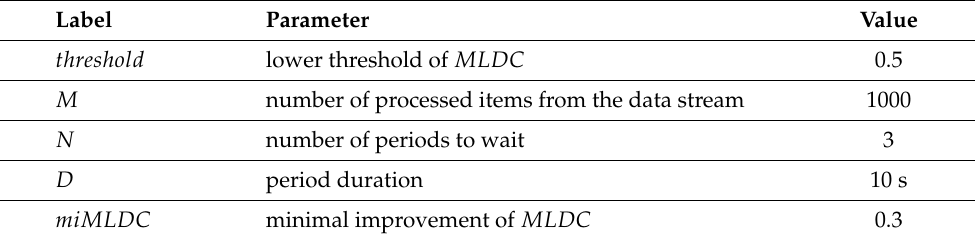
Table 1. Default Parameter Values for the Dynamic